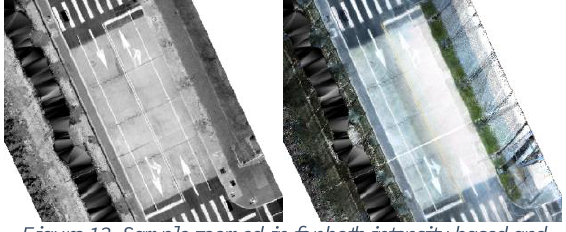
Figure 13. Sample zoomed-in for both intensity-based and color-based images that contain arrows inside tunnels.